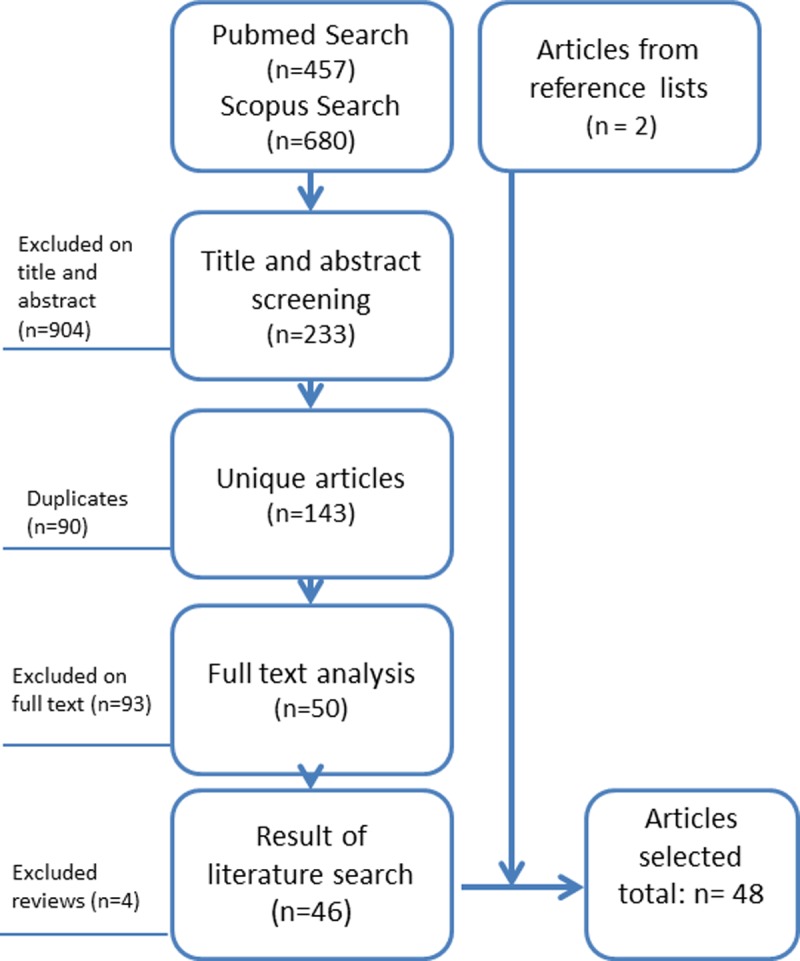
Flow diagram search process.